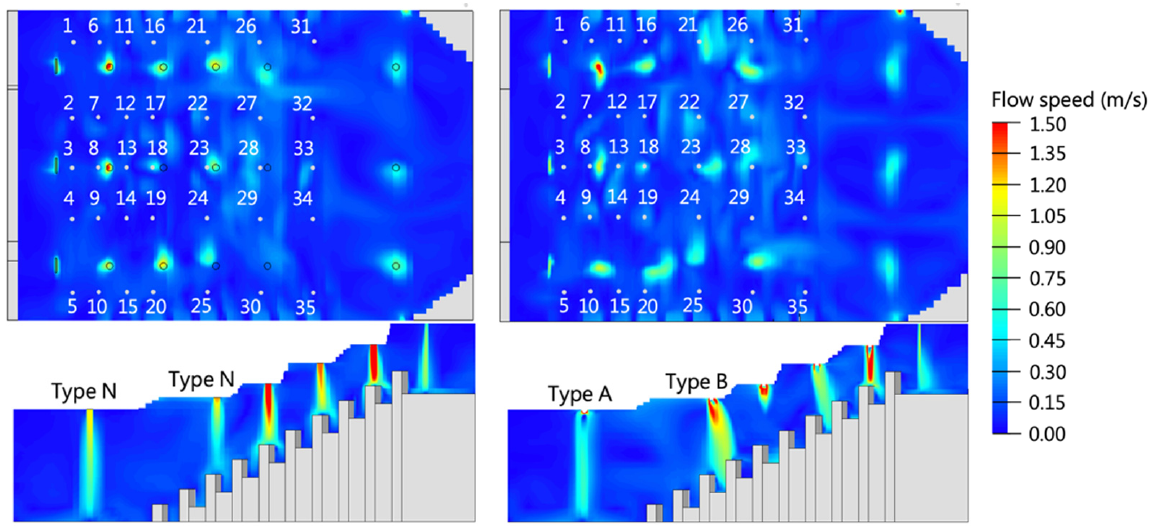
( b ) Figure 14. Simulation results of temperature in ( a ) simplified diffuser model and ( b ) detailed dif- fuser model. Figure 15 shows the air velocity distribution of two simulation schemes. The airflow